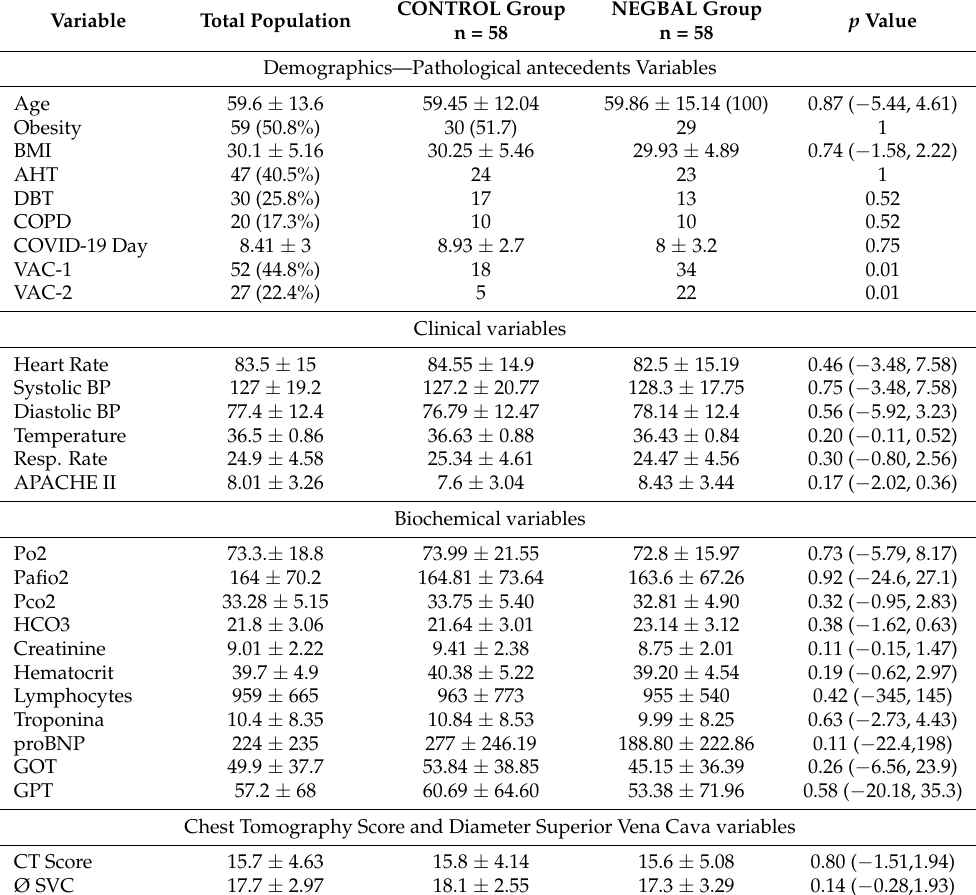
Table 1. Comparative analysis of population with COVID-19 at ICU